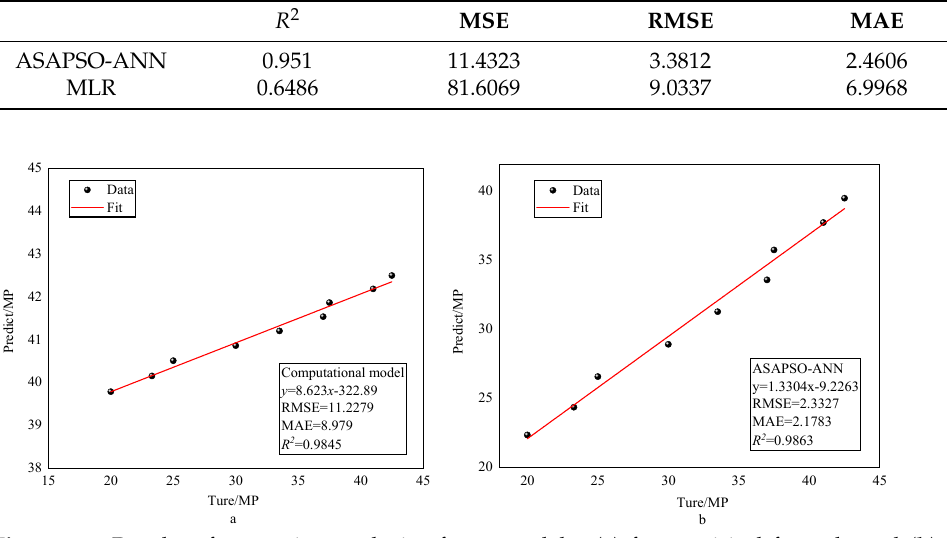
Figure 12. Results of regression analysis of two models: ( a ) for empirical formula and ( b ) for ASAPSO-ANN.